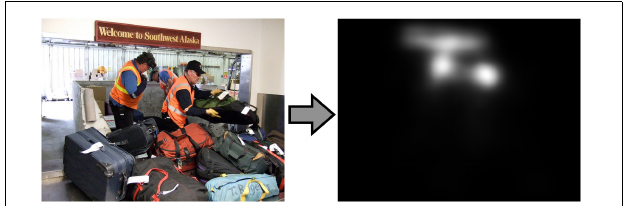
FIGURE 6 | Saliency model. Left: input example that the saliency model can process. Right: corresponding saliency probability distribution that the model produces after training. Here, the most salient regions are the faces and the sign.